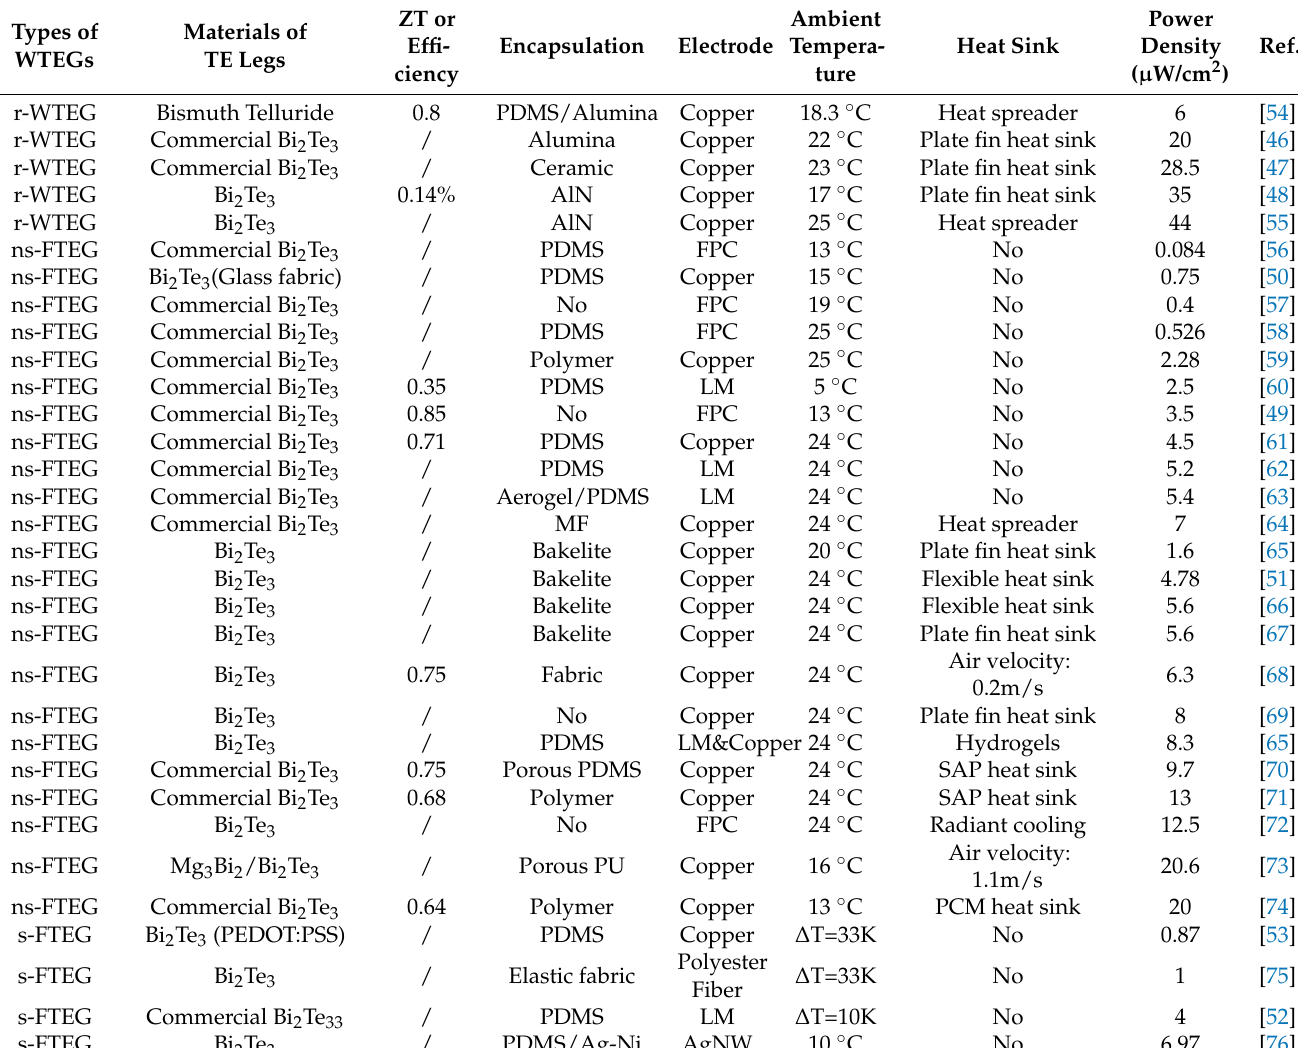
Table 1. Performances and features summary for different types of